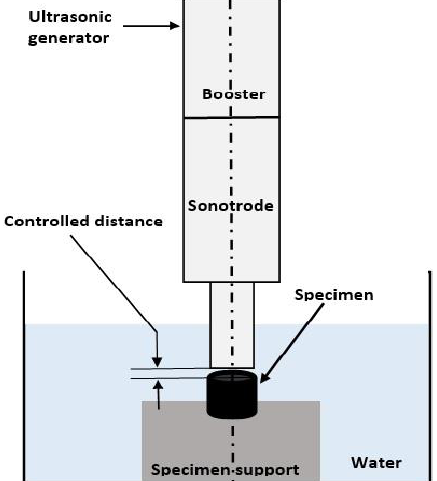
Figure 1. Schematic representation of the indirect cavitation method according to ASTM G-32